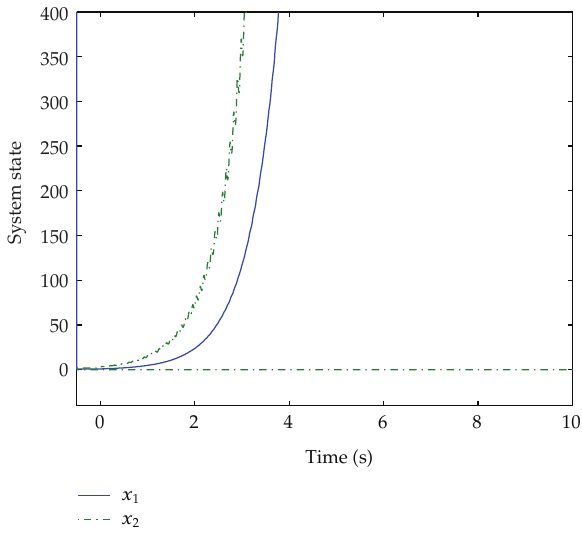
Figure 2: The state trajectories of the open-loop subsystem